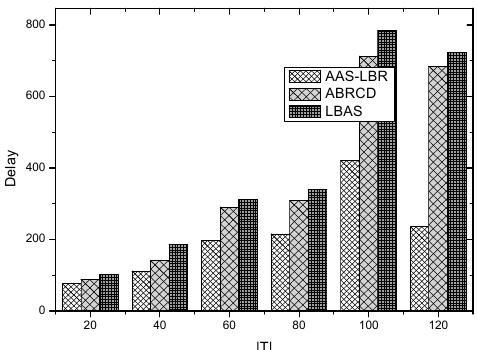
Figure 47. The impact of | T | with fixed network nodes = 400 with fixed on the delay.